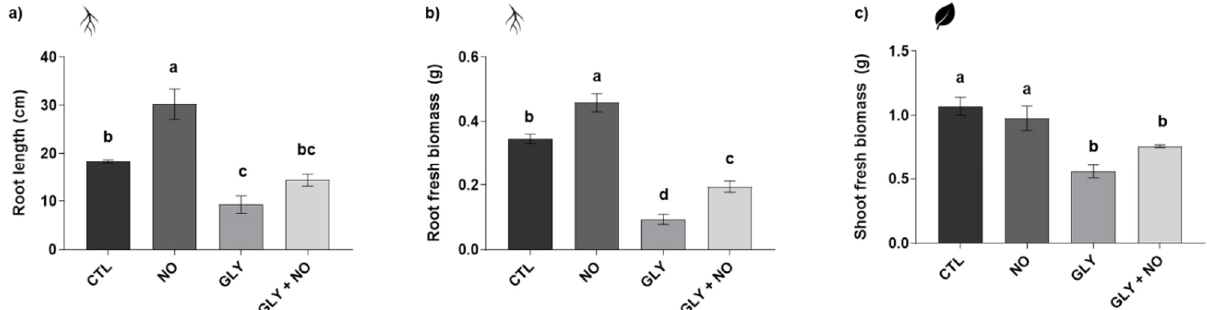
Figure 1. Growth traits of Solanum lycopersicum L. cv. Micro-Tom grown for 28 days in an artificial soil contaminated by GLY (10 mg kg − 1 ) and/or foliar sprayed with SNP (200 µ M): ( a ) root length; ( b ) root fresh biomass; ( c ) shoot fresh biomass. CTL—control plants, grown in the absence of GLY and foliar sprayed with dH 2 O once a week (black); NO—plants grown in the absence of GLY and foliar sprayed with SNP once a week (dark grey); GLY—plants grown in the presence of GLY (grey); GLY + NO—plants grown in the presence of GLY and weekly sprayed with SNP (light grey). Results are presented as mean ± standard deviation (SD) and result from the evaluation of at least three experimental replicates (n ≥ 3). Different letters above bars indicate significant differences between groups (CTL, NO, GLY and GLY + NO) at p ≤ 0.05, according to the one-way ANOVA followed by Tukey’s post hoc test.